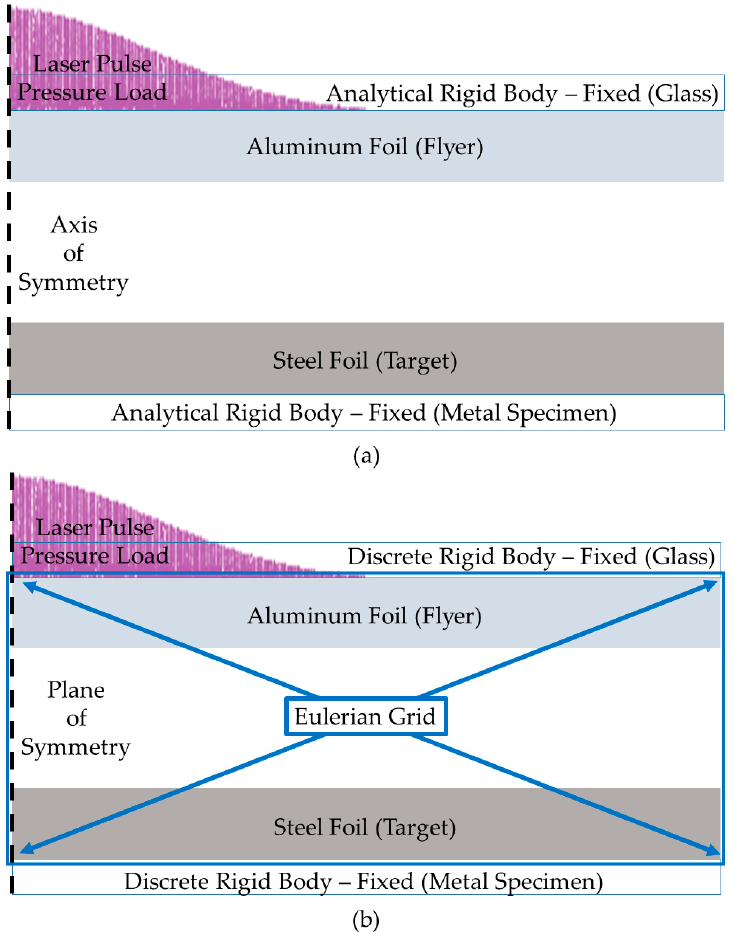
Figure 9. Schematic of the LIW simulations: ( a ) Axisymmetric; ( b ) Eulerian.